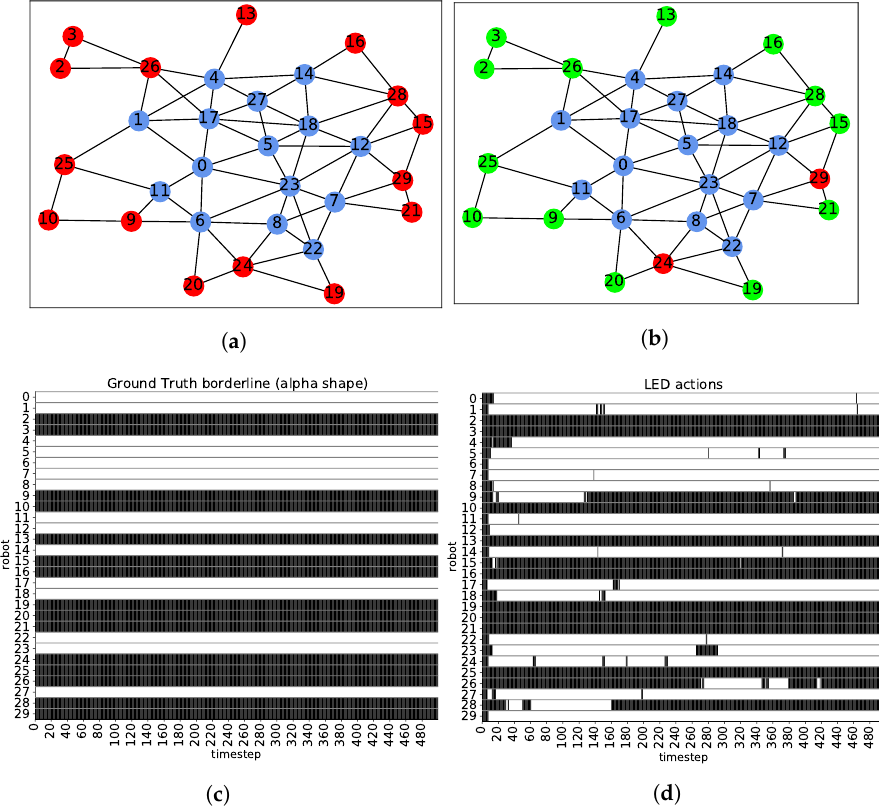
020406080100120140160180200220240260280300320340360380400420440460480 timestep Figure 10. ( a ) Spatial graph of the swarm, edges denote the existence of a pairwise communication channel. Red balls represent alpha shape members and blue dots are interior robots. ( b ) Spatial graph of the swarm, red balls denote agent errors (as indicated in ( d )) and green balls denote correct borderline classifications. ( c ) Target borderline members according to the alpha shape. Horizontal black bars denote frontier robots and horizontal blank bars represent interior agents. ( d ) Temporal evolution of LED actions of the robots as time elapses. Horizontal black bars denote activated LED. ( a ) Swarm topology graph, alpha shape highlighted. ( b ) Swarm graph, successes and errors highlighted. ( c ) Alpha shape. ( d ) LED